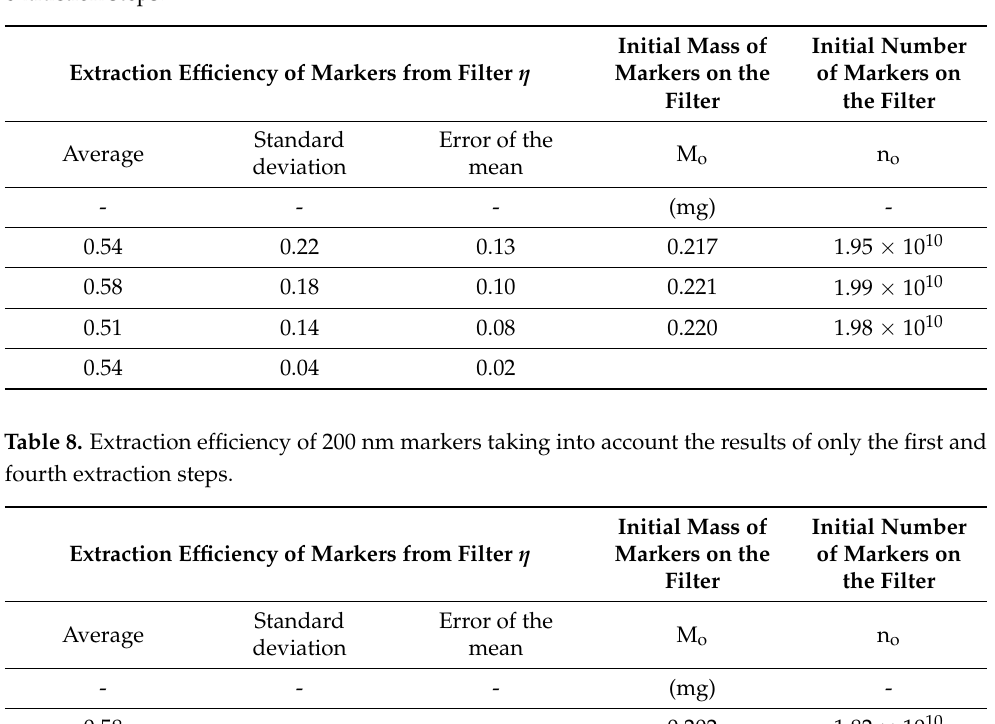
Table 7. Extraction efficiency of 200 nm markers taking into account the results of all subsequent extraction steps.